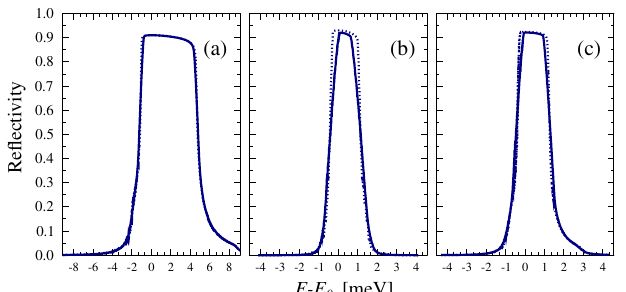
FIG. 7. (Color) X-ray photon energy dependence of the round- trip reflectivity in the four-crystal XFELO cavity (Fig. 6).